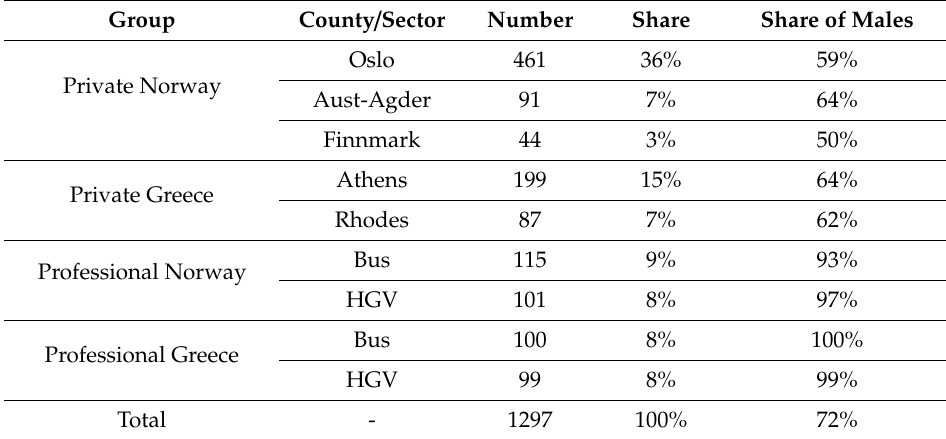
Table 1. Distribution of drivers per city / county and